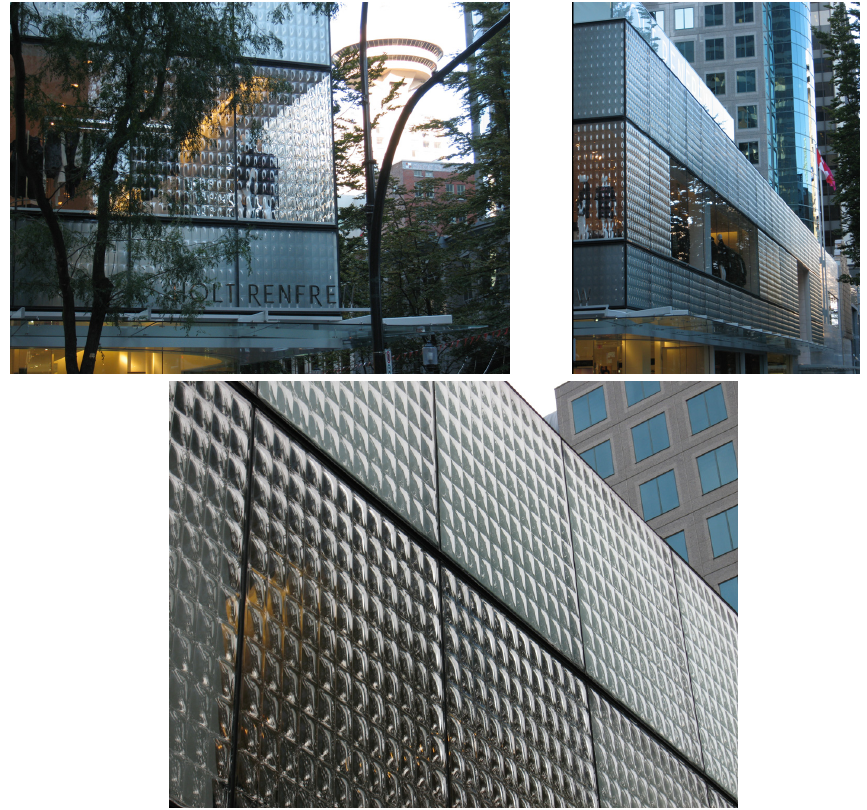
Figure 13a, b, c: Façade Corner View, Long View, Detail